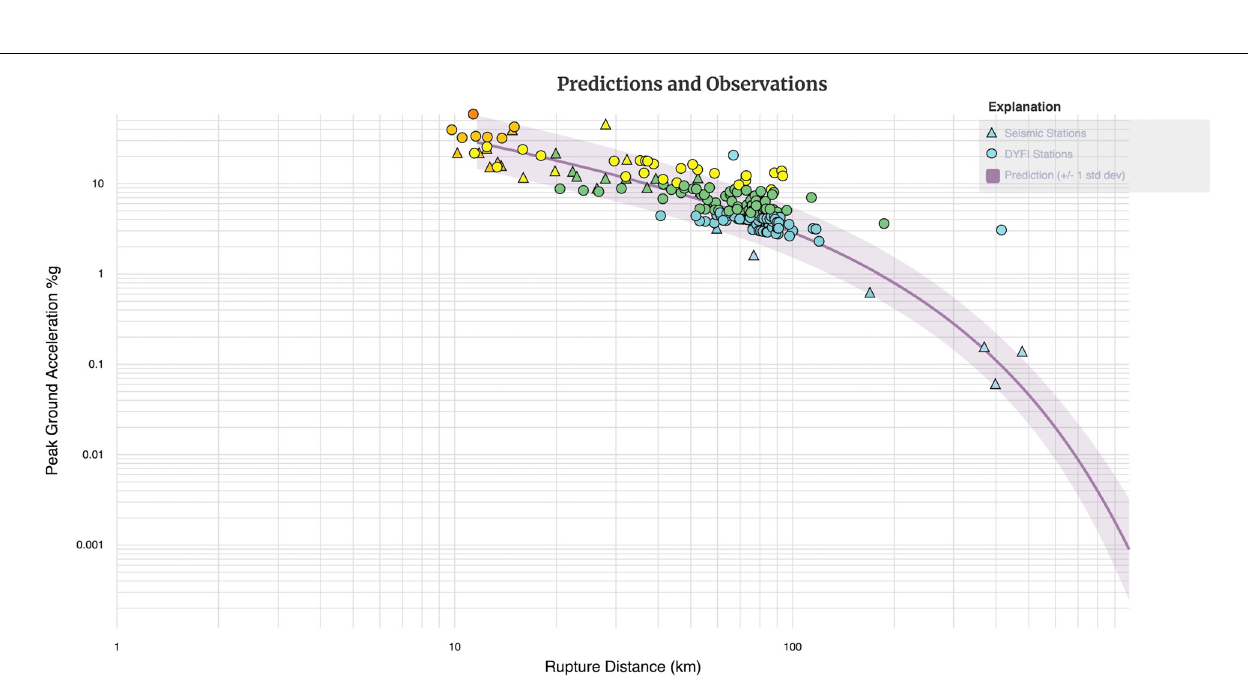
Frontiers in Earth Science |